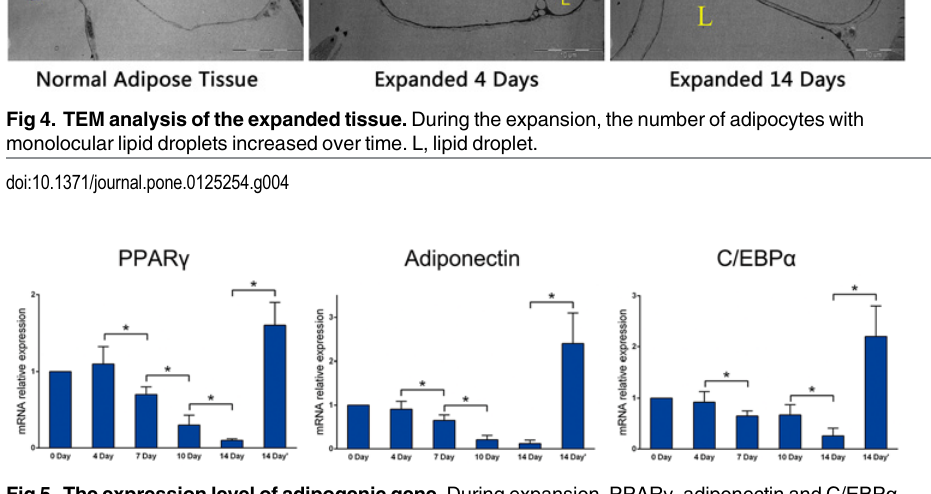
Fig 5. The expression level of adipogenic gene. During expansion, PPAR γ , adiponectin and C/EBP α expression levels decreased gradually. The expression level of them increased significantly after expander removel ( * P <